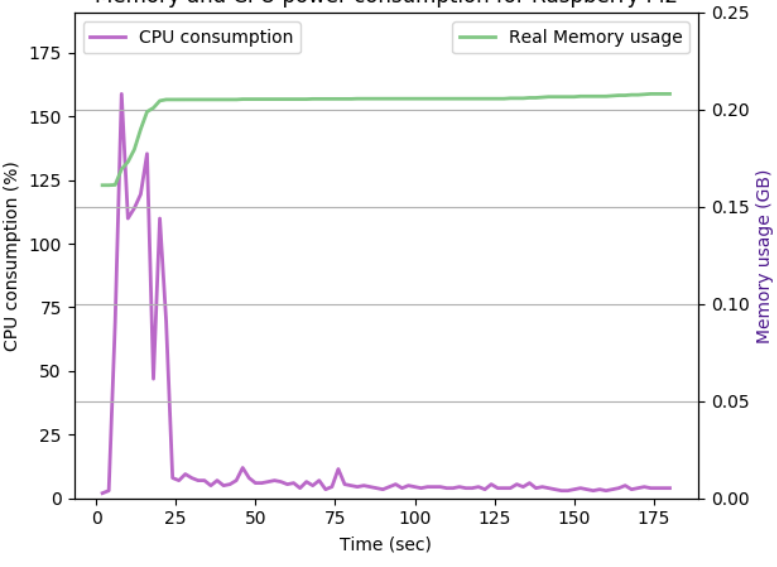
Figure 12. The CPU and memory utilization of the Raspberry Pi device using